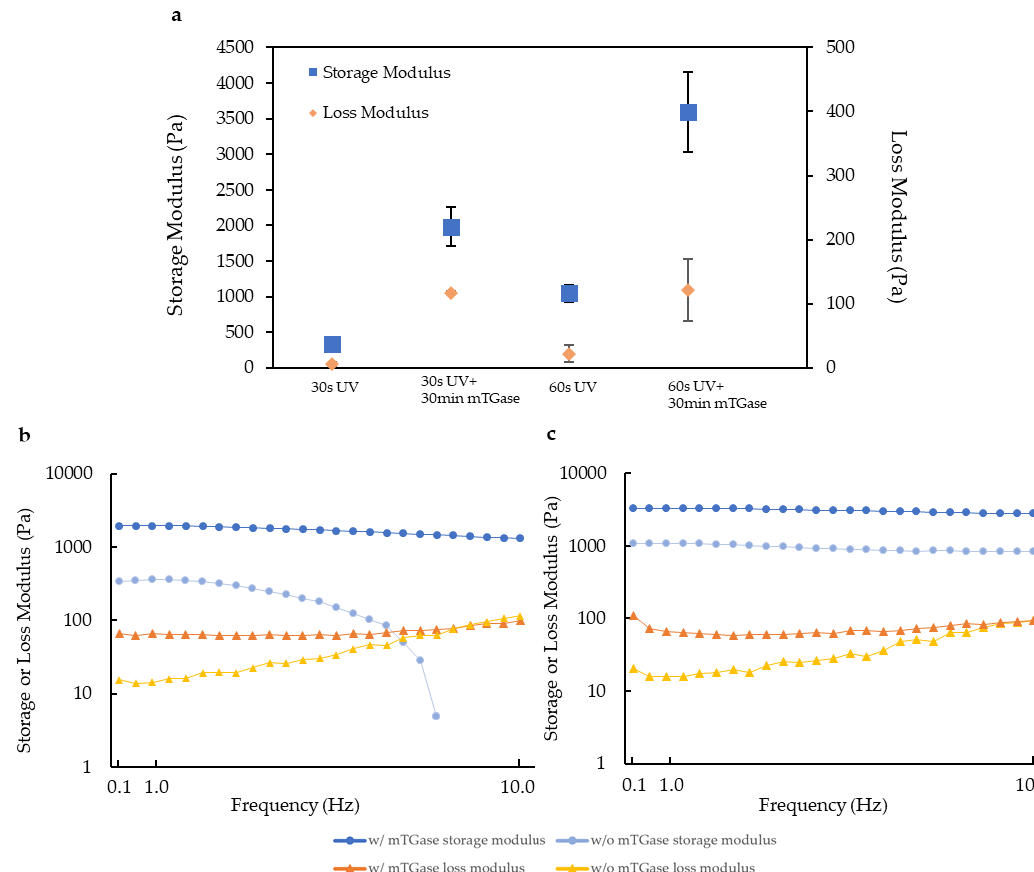
Figure 2. Viscoelastic properties of hydrogels crosslinked with 30 s and 60 s of UV exposure with or without mTGase treatment ( a ) time sweep results ( b ) frequency sweep results for 30 s of UV exposure condition ( c ) frequency sweep results for 60 s of UV exposure condition. (w/: with; w/o: without; mTGase: microbial transglutaminase).